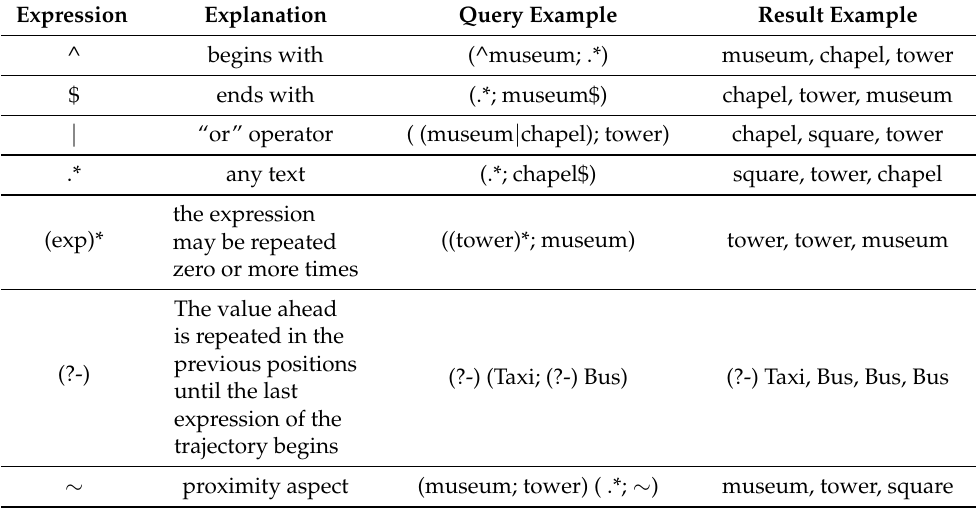
Table 3. List of regular expressions for the semantic path query